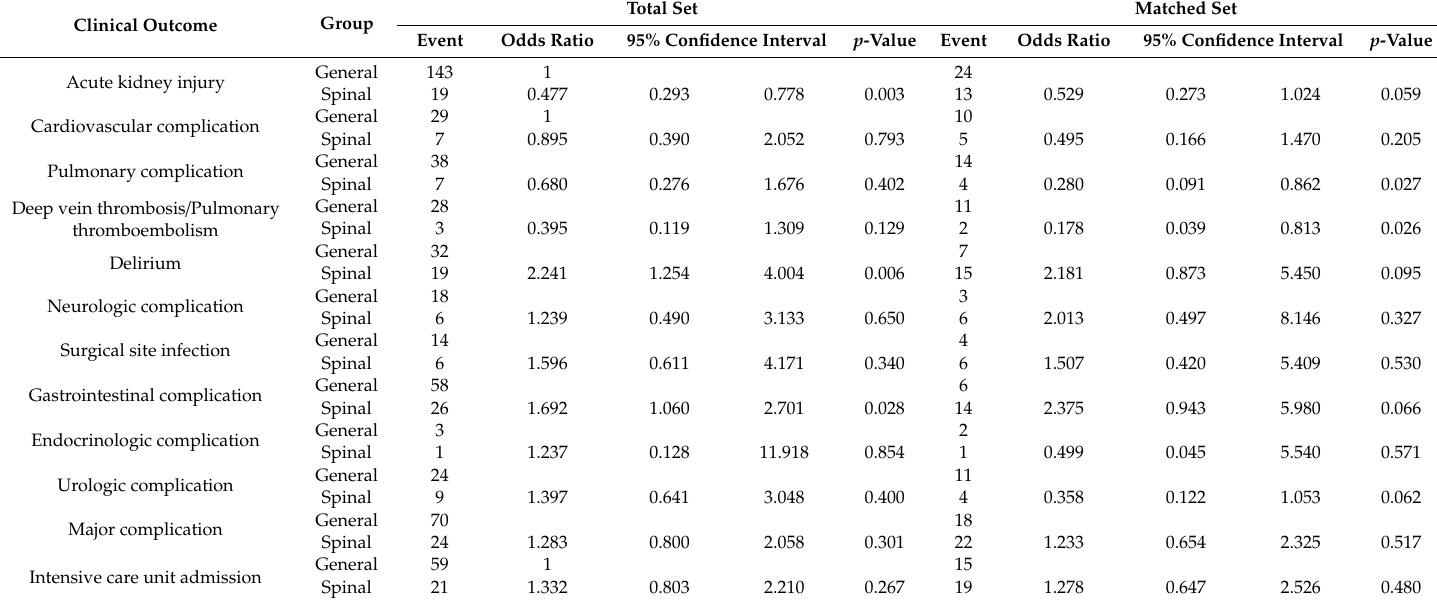
Table 4. Comparison of postoperative clinical outcomes in the study groups by anesthetic